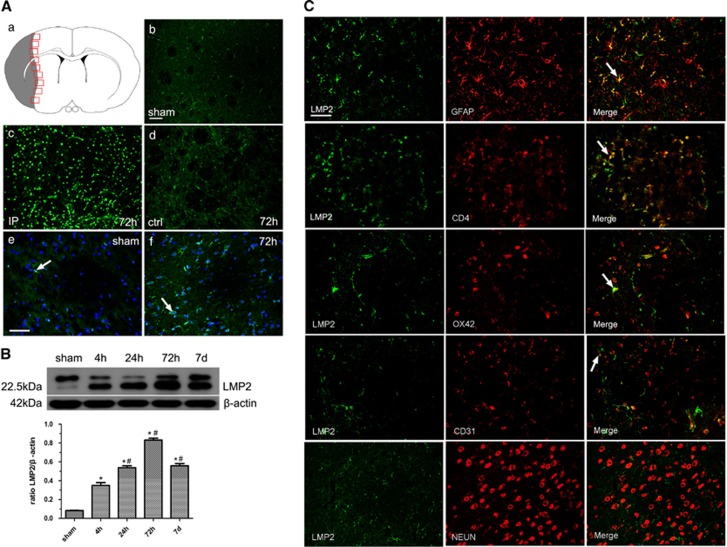
Expression and cellular localization of LMP2 in the brains of MCAO rats. (A) A schematic representation of a coronal brain section. The square fields represent observed regions (a). There was only sparse weakest immunoreactivity of LMP2 in glia-like cells in the cortex and striatum in non-ischemic hemisphere and sham-operated control rats (b). In contrast, the number of cells expressing strong LMP2 immunoreactivity was significantly higher in the ipsilateral ischemic hemisphere than in the contralateral hemisphere at different time points (c and d, 72 h time point was shown here). LMP2 was mostly localized in cell nucleus in non-ischemic hemisphere whereas LMP2 was evident in both the nucleus and the cytoplasm after MCA occlusion (arrow) (e and f). Five rats in each group were used for immunofluorescent assays (n=5). (B) Western blot showed that LMP2 protein levels were significantly elevated in the ipsilateral cerebral cortex and striatum all time points when compared with sham-operated control animals. Quantification analysis confirmed that the level of LMP2 protein changed from 4 h to 7 days in the ipsilateral ischemic cortex and striatum (*P<0.001, compared with the controls; #P<0.001 compared with the previous time point) (B). Five rats in each group were used for western blot (n=5). (C) Double immunostaining showed that the overwhelming majority of LMP2 (green) was colocalized with glial fibrillary acid protein (GFAP)-positive astrocytes (red) although some LMP2-positive cells were colocalized with CD4+T lymphocytes (red), with OX42-positive microglia/macrophage cells (red) and with CD31-positive vascular endothelial cell (red) (arrow). In contrast, LMP2-positive cells were not colocalized with NEUN-positive neurons (red) at any time points (figure 1C). Scale bars=80 μm (in A: b–d), 50 μm (in A: e and f, C). IP, ipsilateral hemisphere; ctrl, contralateral hemisphere; sham, sham-operated control rats